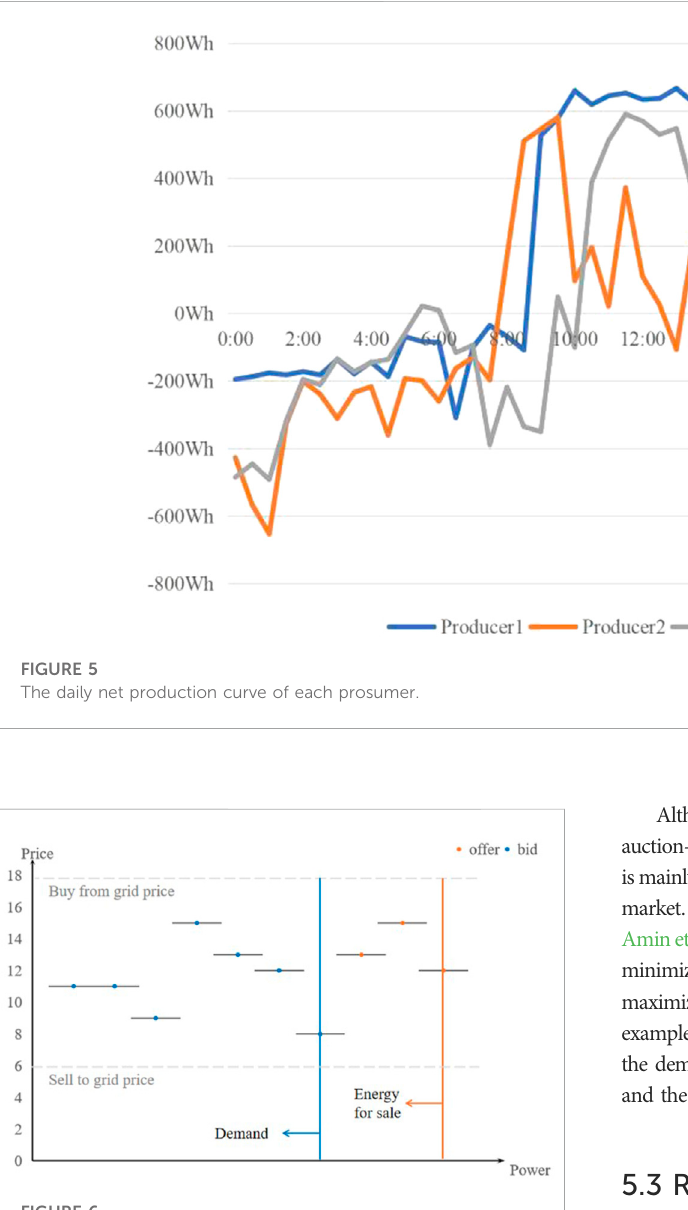
FIGURE 6 Auction-based pricing